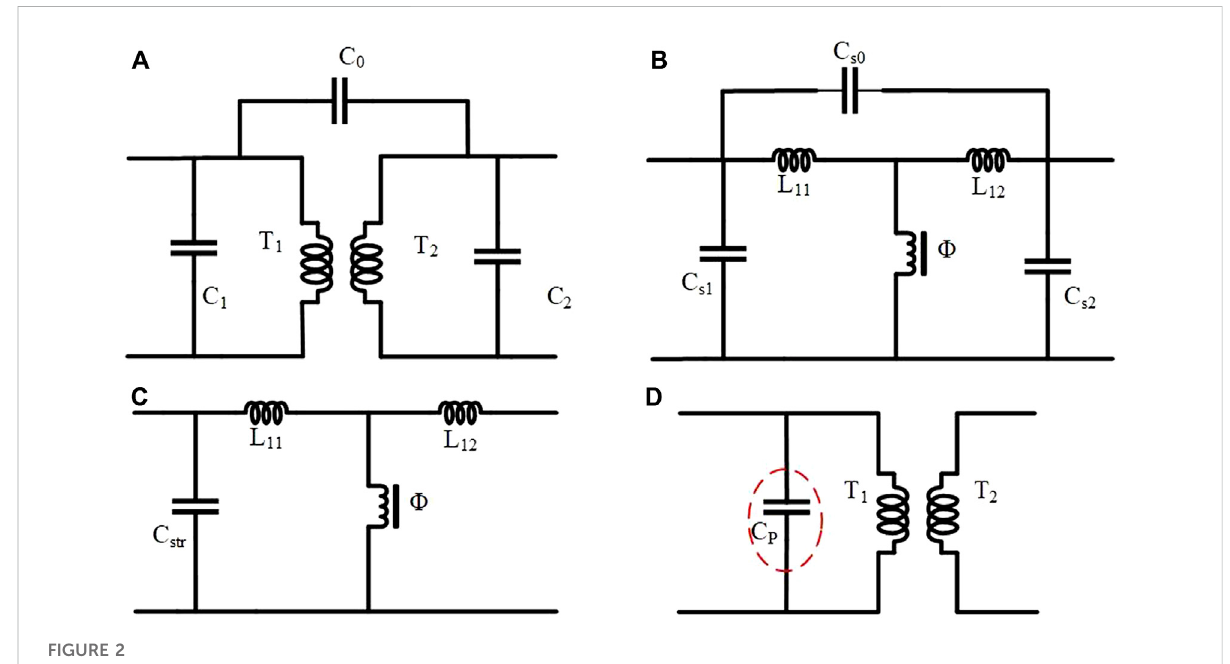
FIGURE 2 (A – D) The model considering parasitic